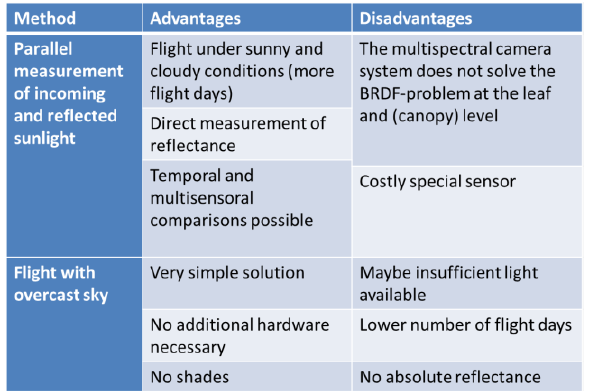
Table 1: Comparison between the use of a radiometrically calibrated camera vs. a drone flight with overcast sky